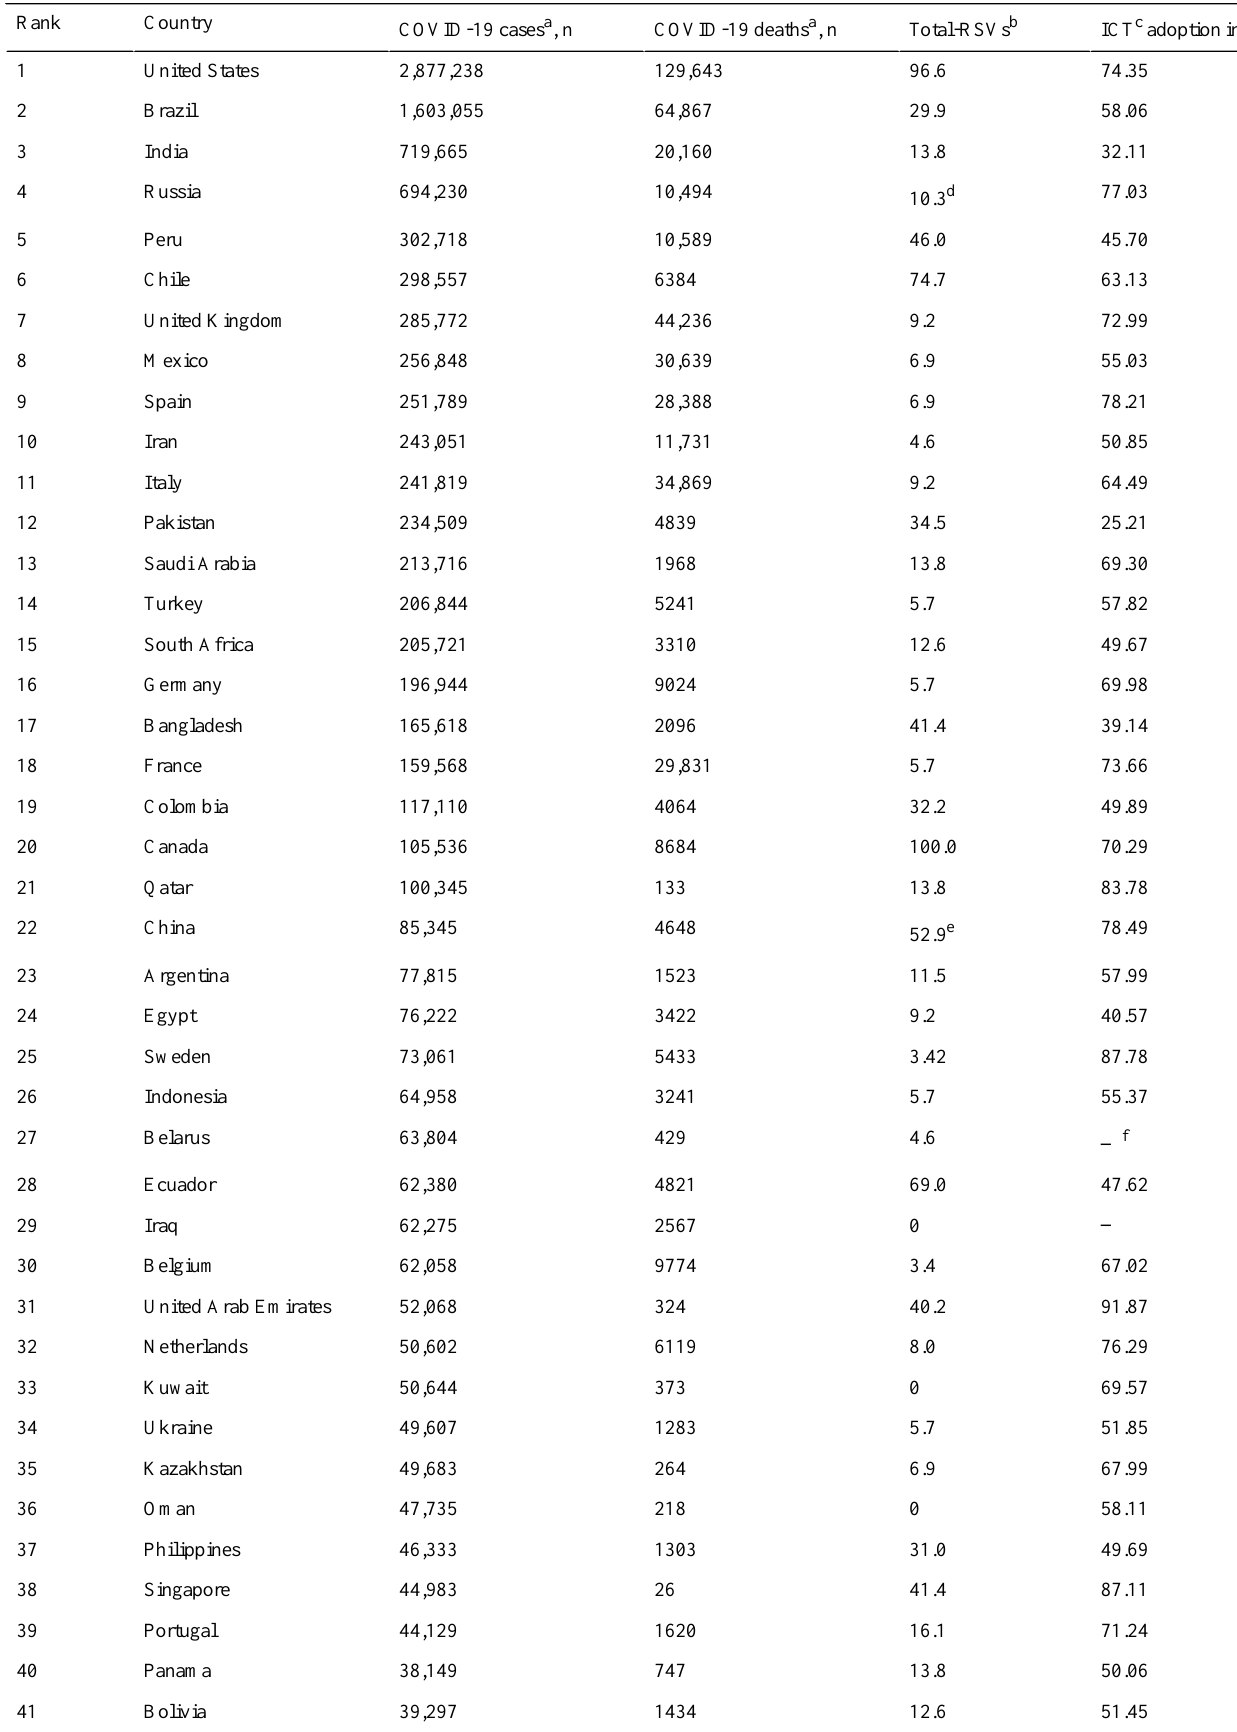
Table 1. Key COVID-19 and telehealth-related parameters for the top 50 countries most affected by the